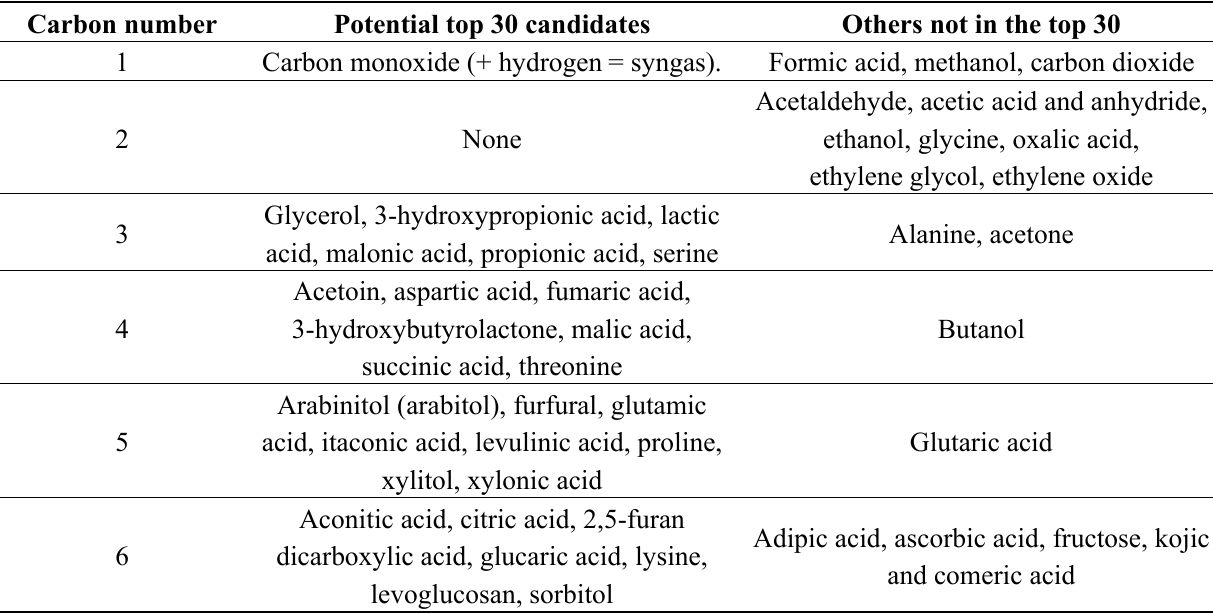
Table 1. Potential top 30 value-added chemicals produced from biomass [25]. Carbon